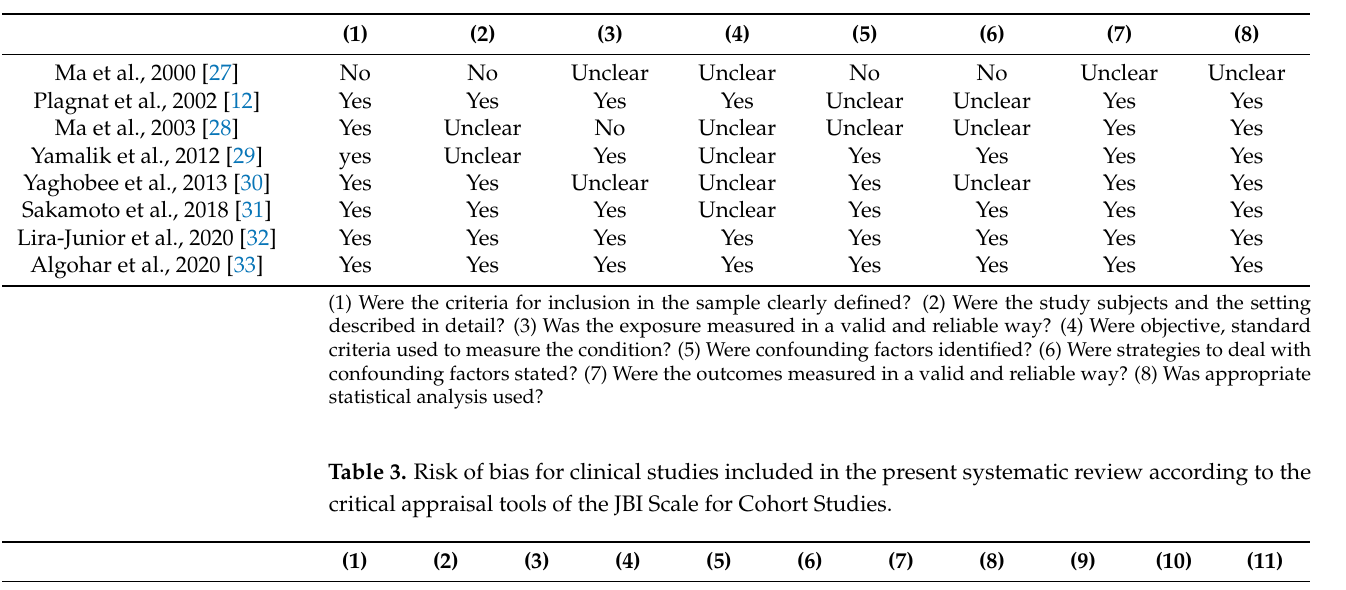
Table 2. Risk of bias for clinical studies included in the present systematic review according to the critical appraisal tools of JBI Scale for analytical cross-sectional studies.